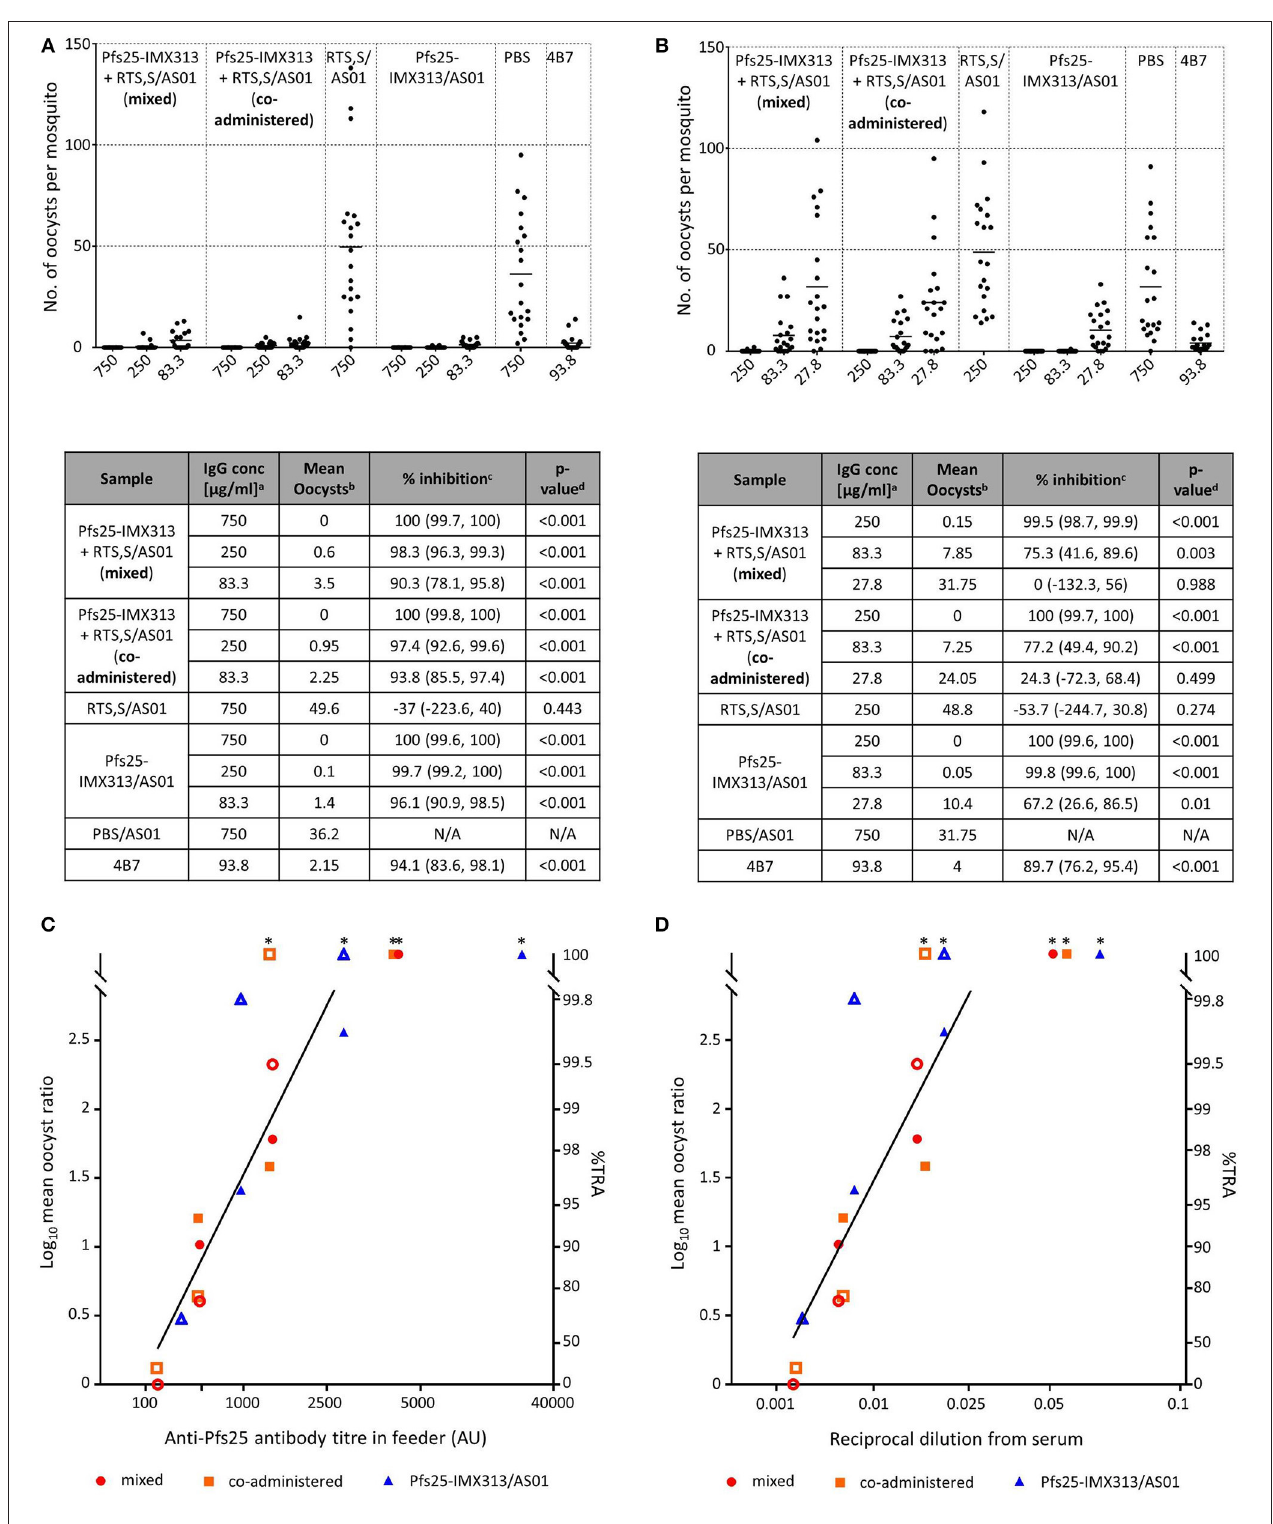
FIGURE 4 | Transmission blocking activity of anti Pfs25-IgG induced by immunization with Pfs25-IMX313 alone or in combination with RTS,S. (A,B) Total IgG, purified from pooled serum of each group (2 weeks post boost) was tested in SMFA in two independent experiments, one using total IgG concentrations of 750, 250 and 83.3 µ g/ml (A) and one using total IgG concentrations of 250, 83.3, and 27.7 µ g/ml. The transmission blocking monoclonal anti-Pfs25 antibody